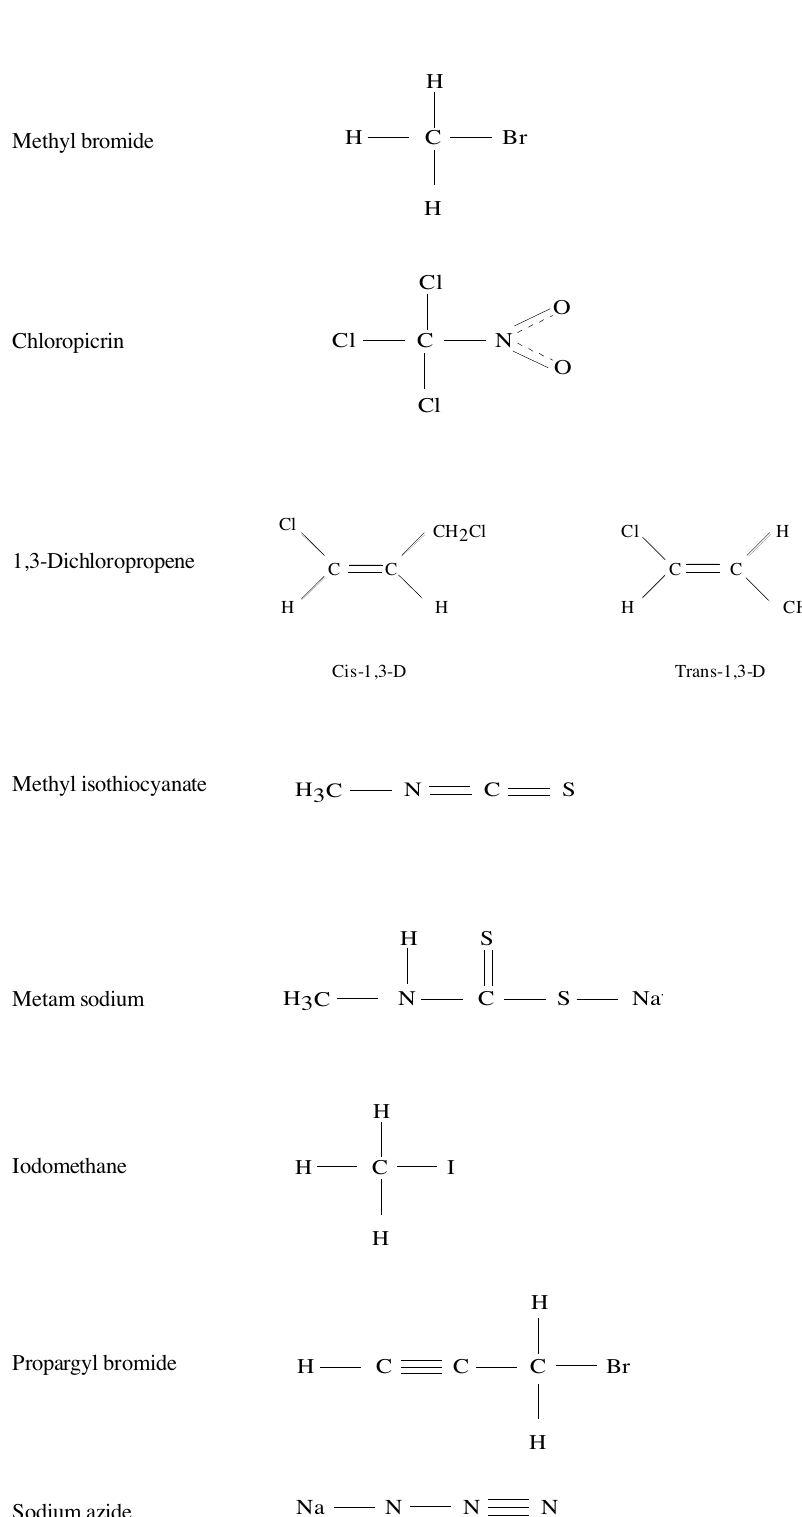
Fig. 1. Chemical structure of methyl bromide and selected alternative